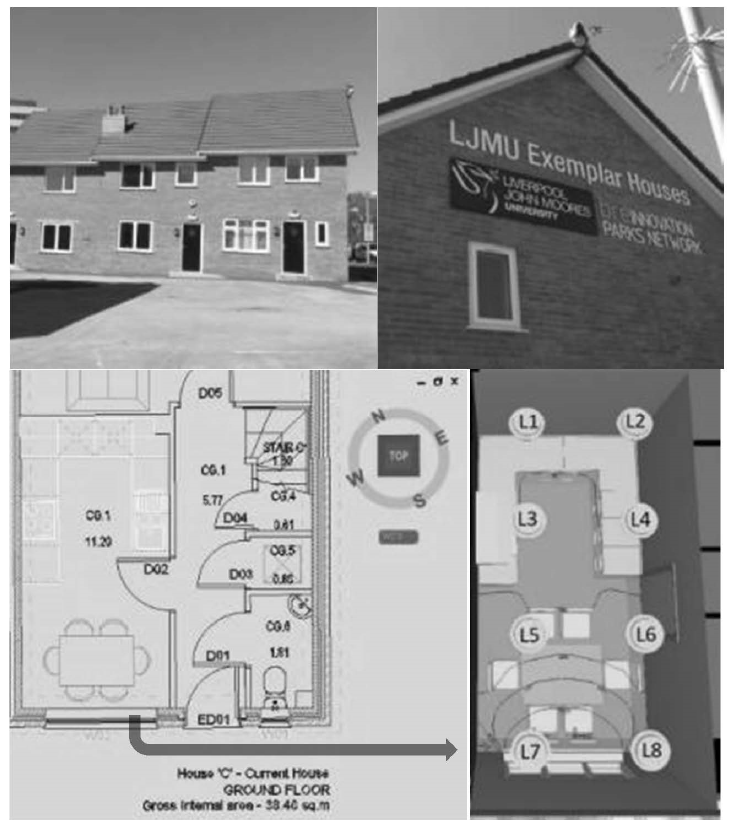
Figure A1. Liverpool John Moores University (LJMU) Exemplar houses ( top ). The Computer-aided Design (CAD) drawing and lighting DIALux model ( bottom ).